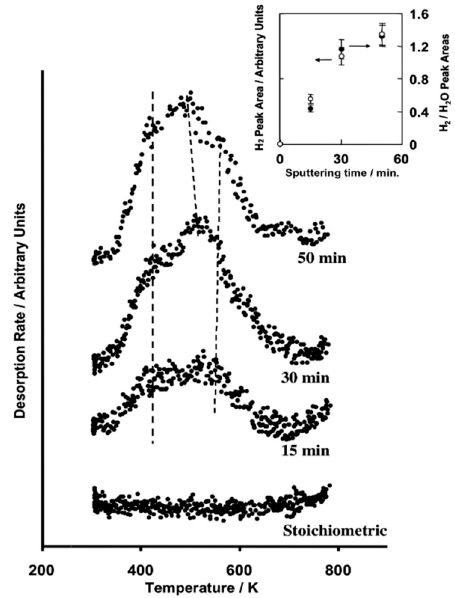
Figure 7. Temperature programed desorption of H 2 after H 2 O adsorption at 300 K over Ar + sputtered UO 2 (111) single crystal [58]. The inset shows the computed H 2 peak area as well as the H 2 /H 2 O peak area ratios.